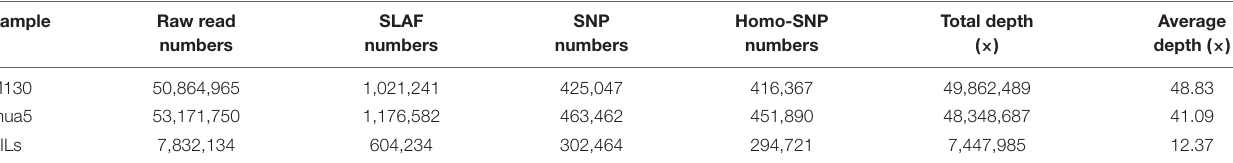
TABLE 4 | Summary of SLAF numbers and marker